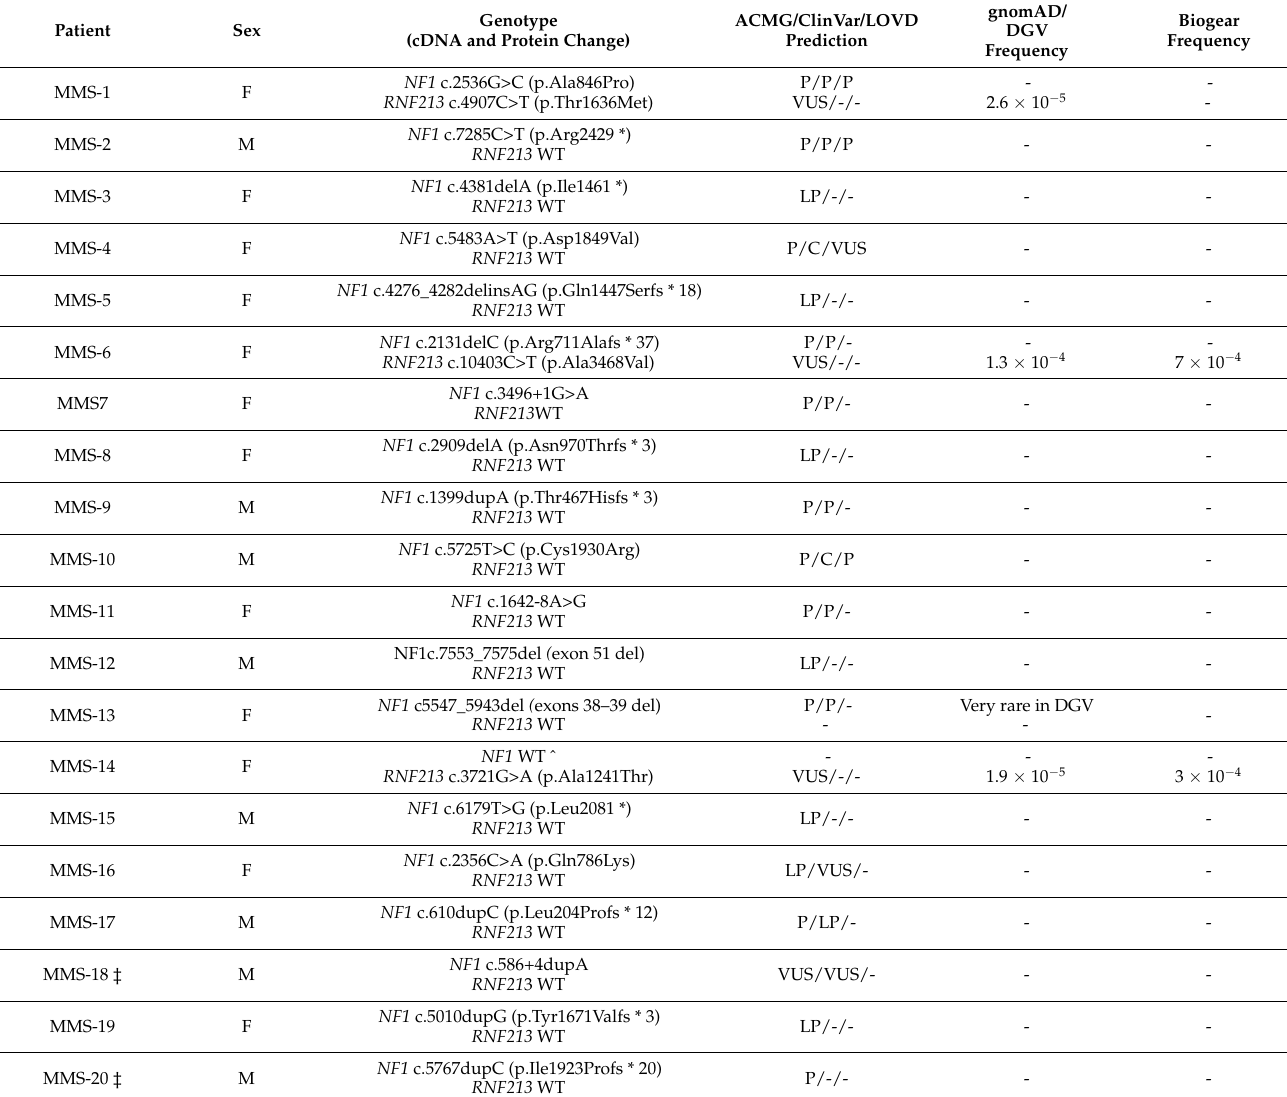
Table 2. NF1 and RNF213 rare variants identified in MMS patients.